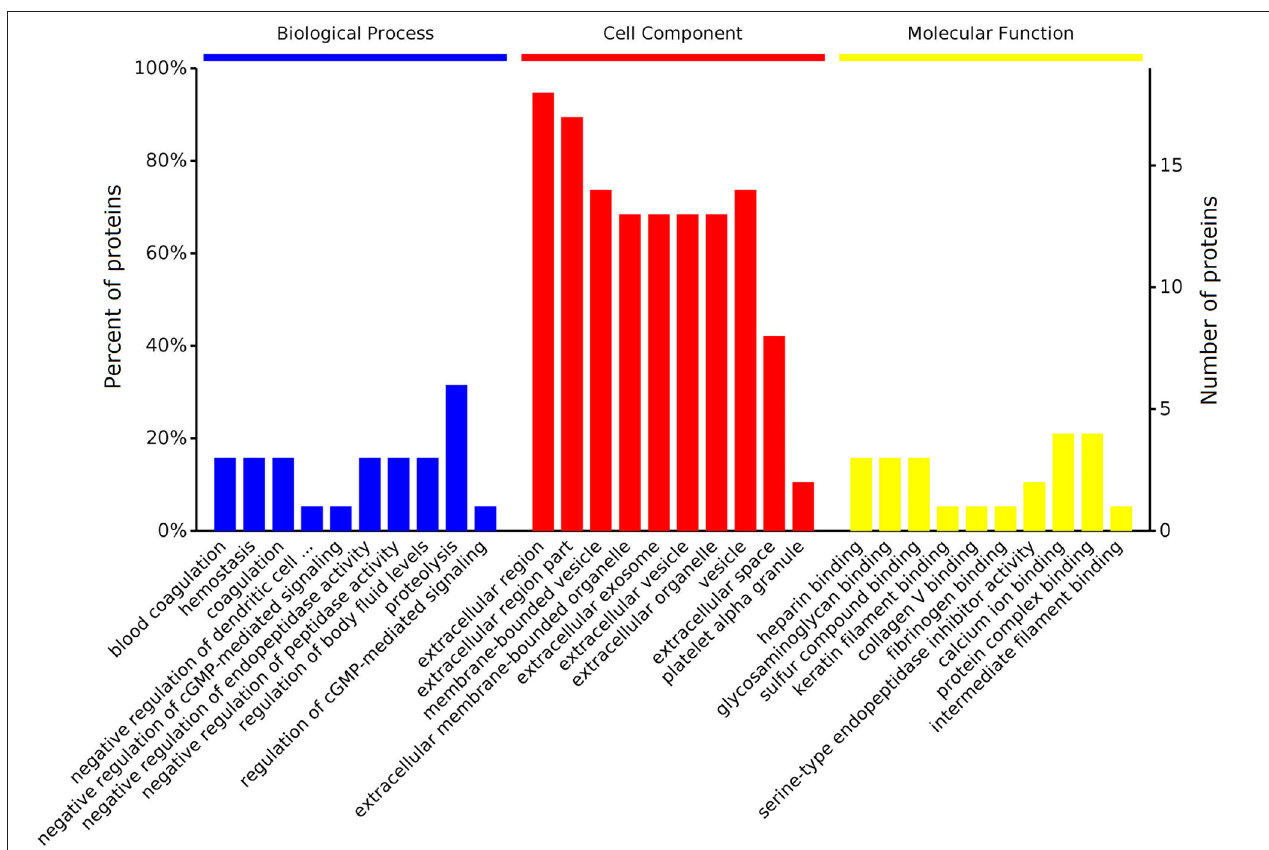
FIGURE 3 | GO enrichment analyses of DEPs identified in the serum of early pregnant and non-pregnant jennies. Most proteins could be divided into three major categories: biological process, cellular component, and molecular